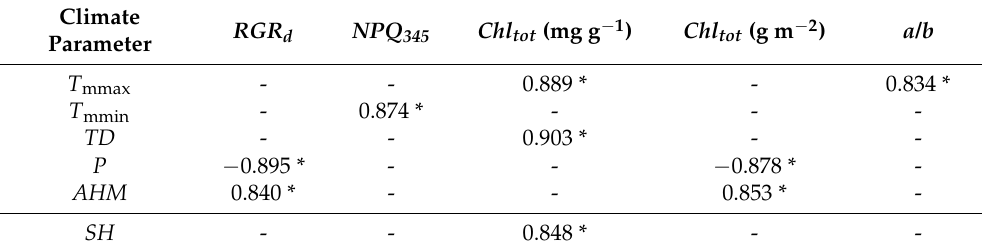
Table 6. The relationships between the climate characteristics of the mother stands and mean values per provenance of growth and leaf traits. Pearson’s coefficients of correlation ( r ), together with the values of probabilities, are given.